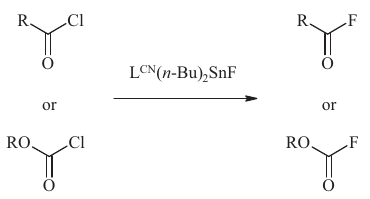
Figure 10 Use of L CN ( n -Bu) and fl